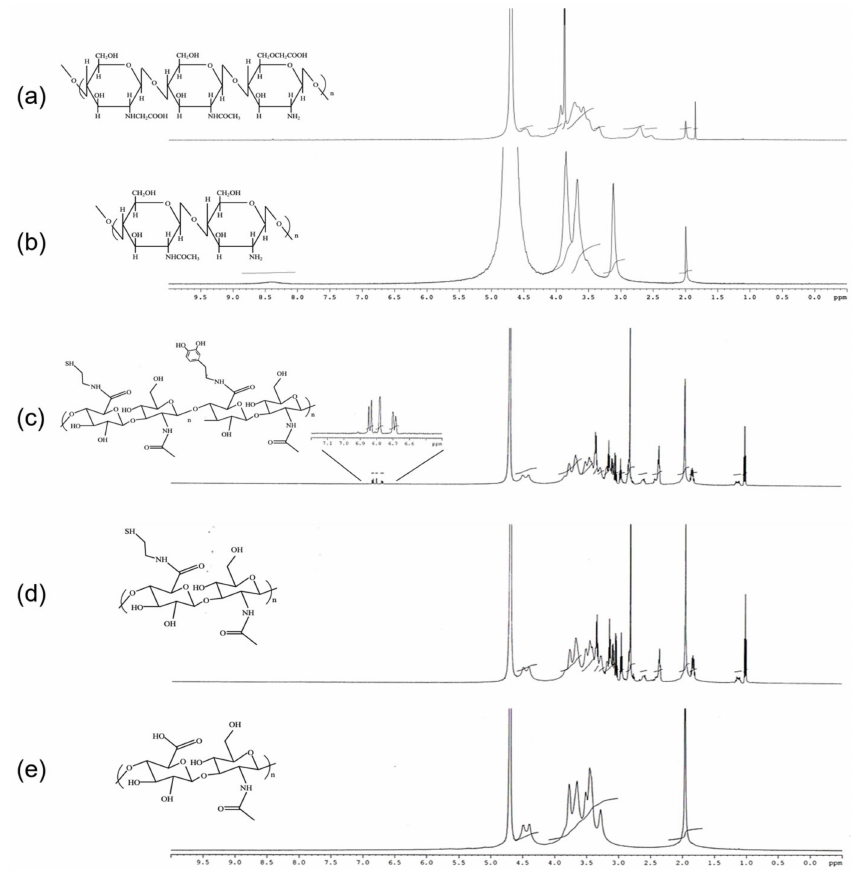
Figure 1. 1 H-NMR spectra of ( a ) NOCC, ( b ) CS, ( c ) SH-HA-Dopa, ( d ) HA-SH and ( e ) HA. Individually, the average EE% values of Dox and siRNA were 73.3 ± 1.4% and 89.8 ± 0.1%, respectively. For the drug part of the co-delivery system, HA-SH was used